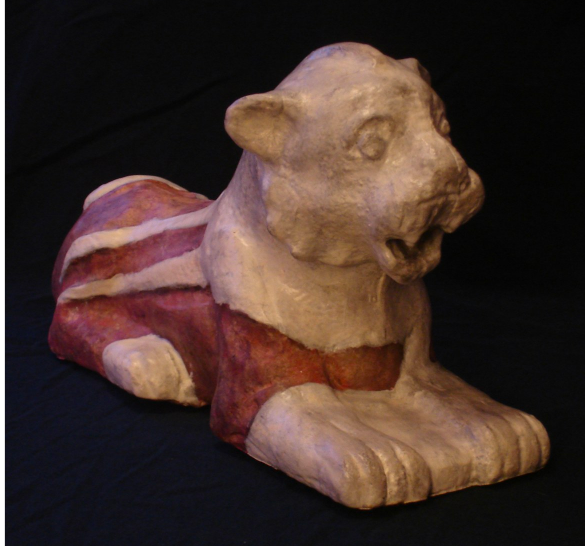
Figure 2. The application of 3D printing on virtual restoration in the Harvard Semitic Museum (Flasherty,